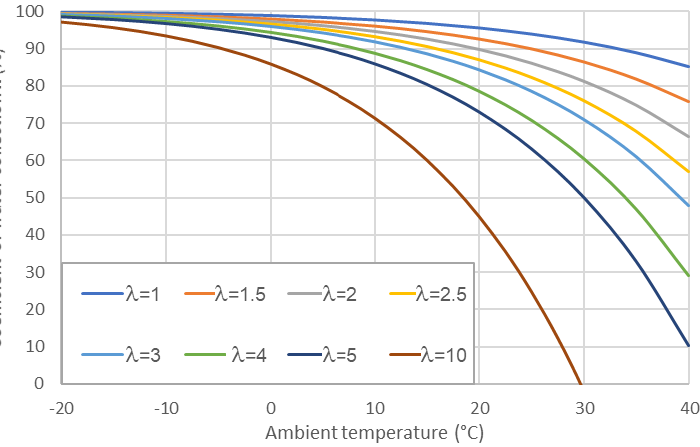
Figure 4. The part of condensed water from water circulating in the system ( k ), as calculated for various ambient temperatures ( T amb ) and stoichiometries λ